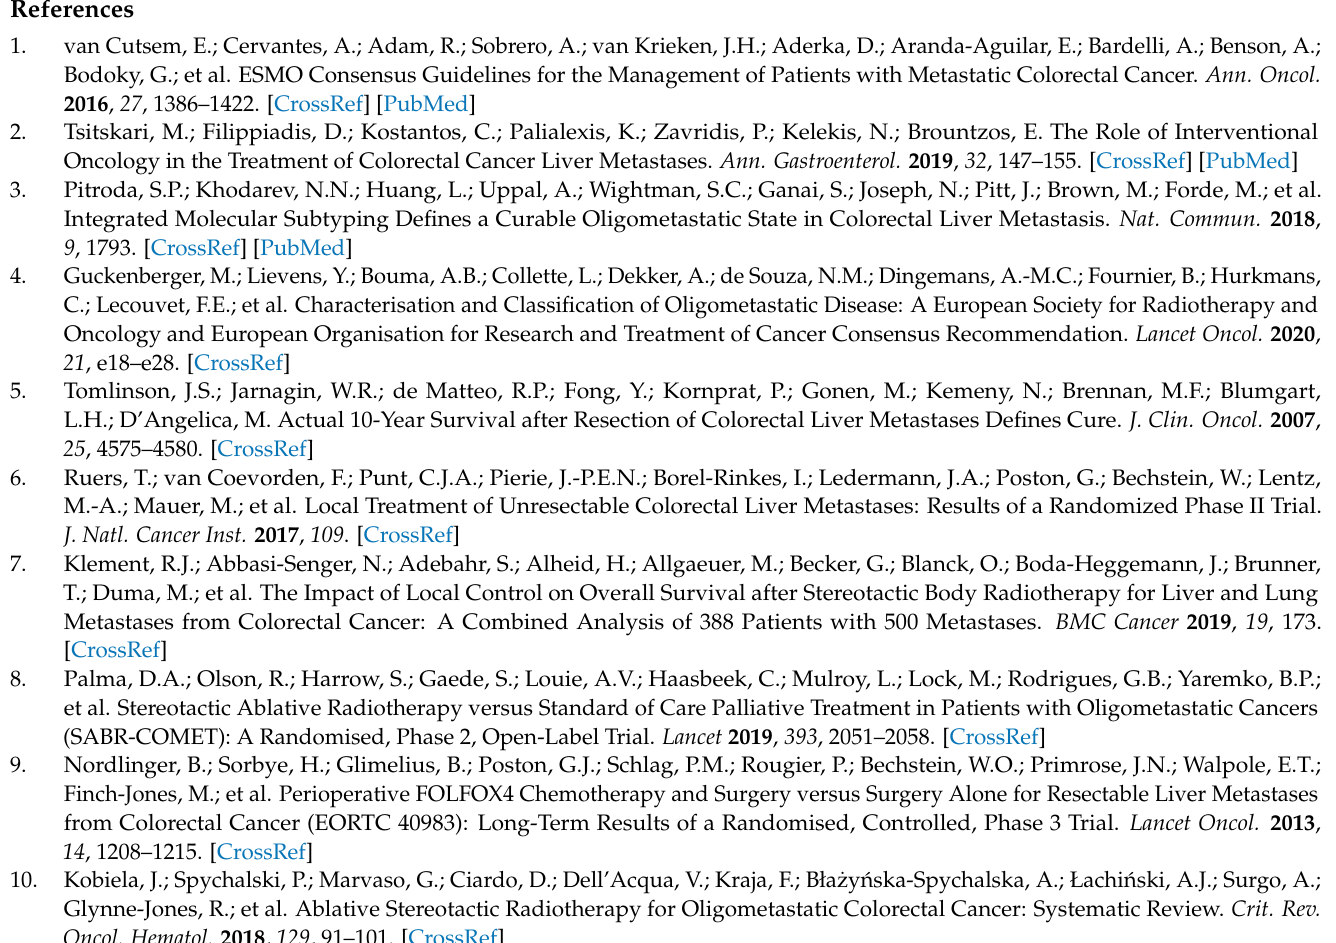
Table S2: QLQ-C30 score differences between baseline and 9-month